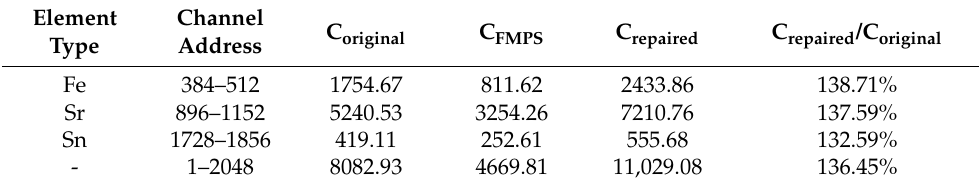
Table 2. Comparison of the counting rates before and after multiplication. (The pulse circulation method and the FMPS algorithm are used at the same